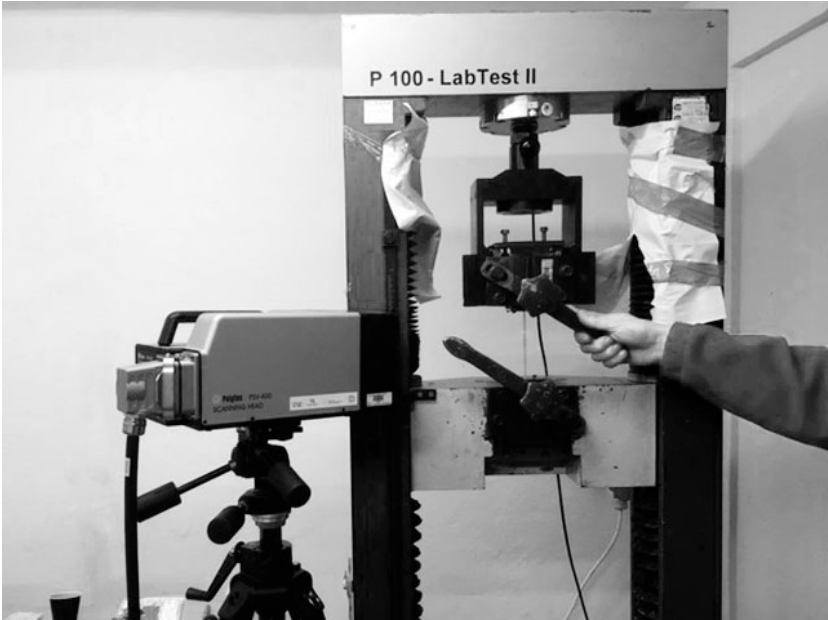
Figure 2. The general view of the experimental setup.